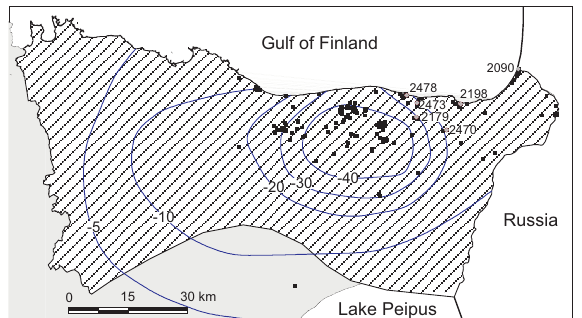
Fig. 3. Location of V 2 vr monitoring wells for background data (solid squares) and for detailed studies (grey points marked with the well number). Solid lines (m) represent the maximum of the regional cone of depression in 1995 according to Perens & Vallner (1997).